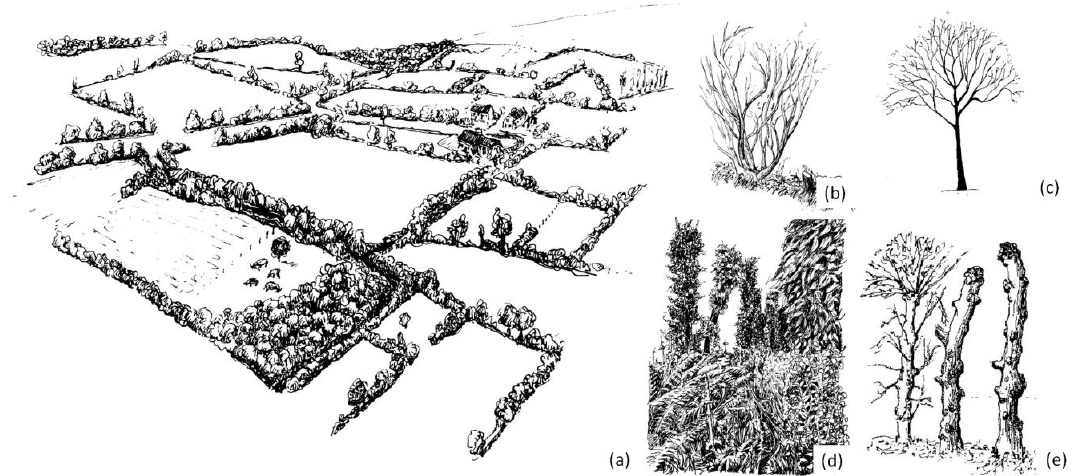
Figure 1. Linear fragmentation of a hedgerow network ( a ) presenting different canopy structures; ( b ), ( c ), with ( d ) or without ( e ) underlaying and pruned (drawing by Y. Le